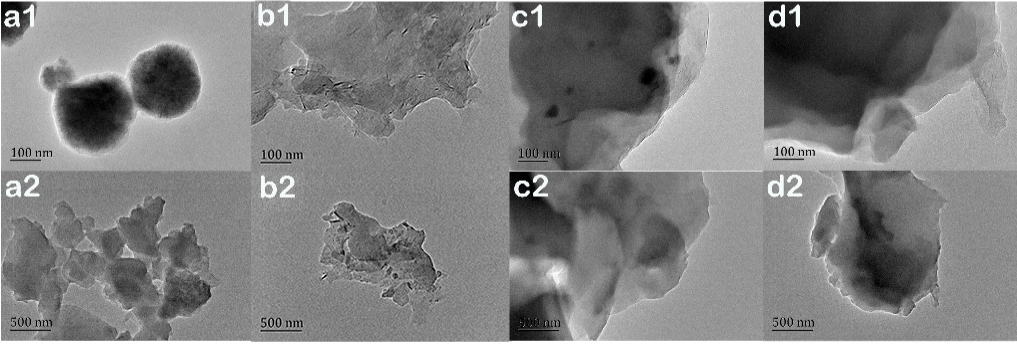
Figure 4. TEM images of EP-POSS nanocomposite film. ( a1 , a2 ) EP-POSS, ( b1,b2 ) EP-POSS/SiO 2 /graphene, ( c1,c2 ) EP- POSS/ZnO/graphene, ( d1,d2 ) EP-POSS/graphene.